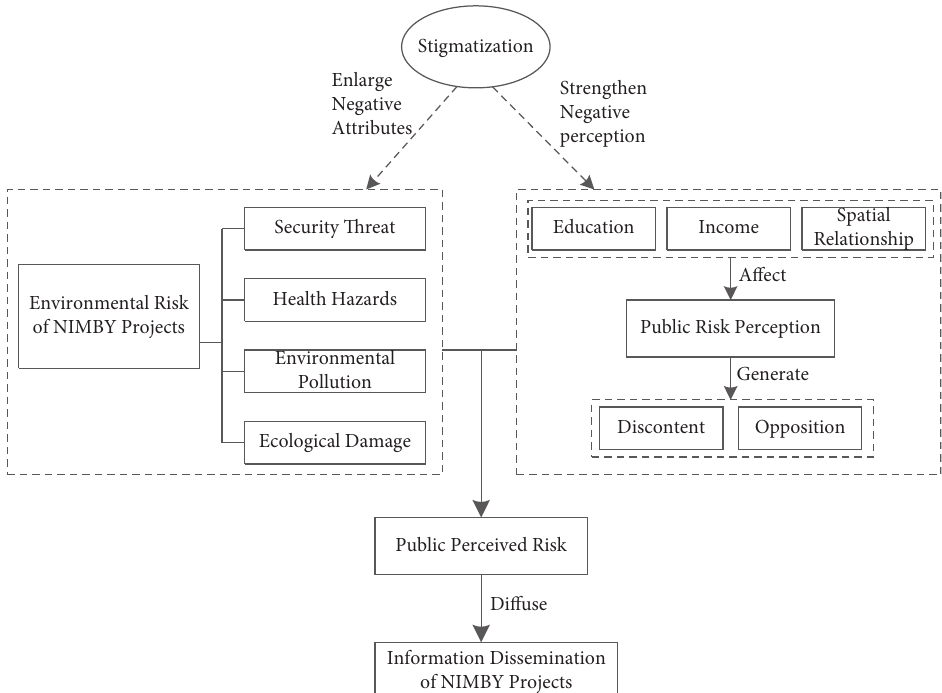
Figure 1: Impact path of stigmatization on information dissemination of NIMBY project.